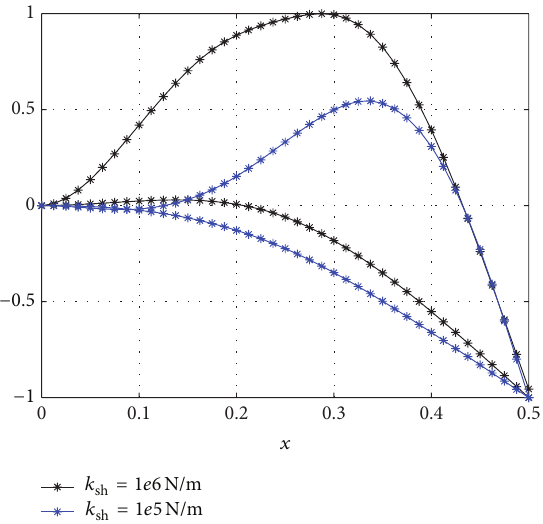
Figure 7: First two proper orthogonal modes of the nonlinear system with different 𝑘 sh